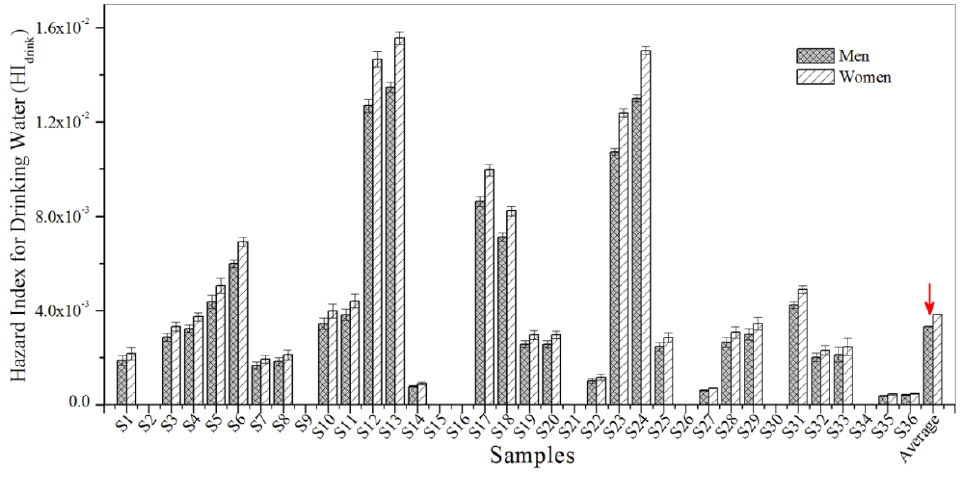
Figure 5. The HI drink for BBP in the urban sewage samples.